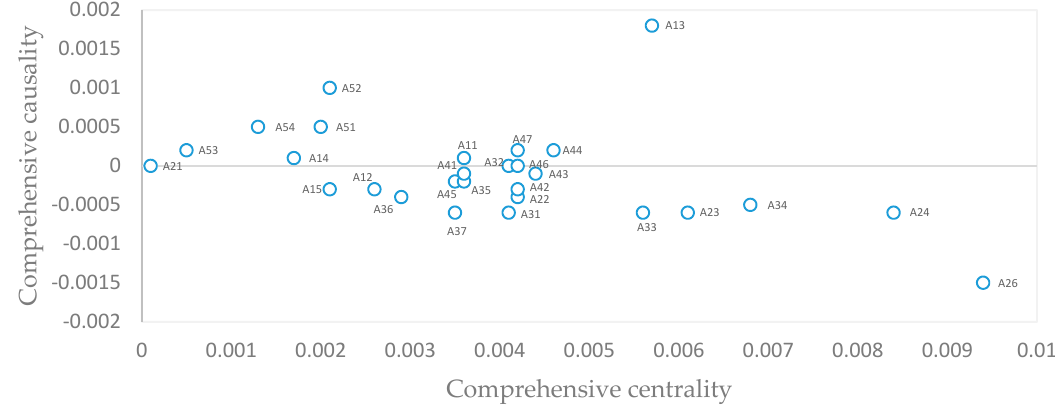
Figure 3. Distribution of comprehensive influencing degrees of factors.